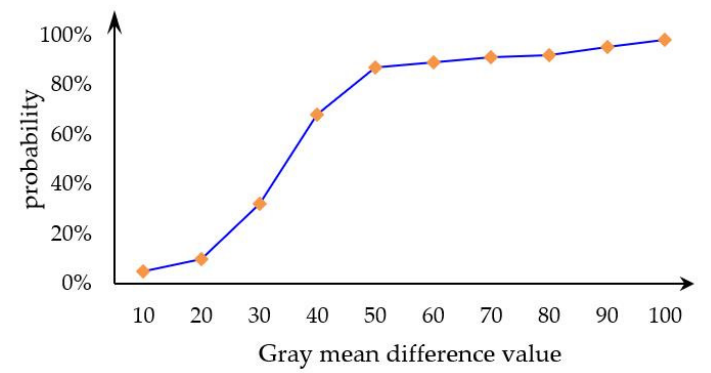
Figure 13. Gray mean difference threshold analysis.